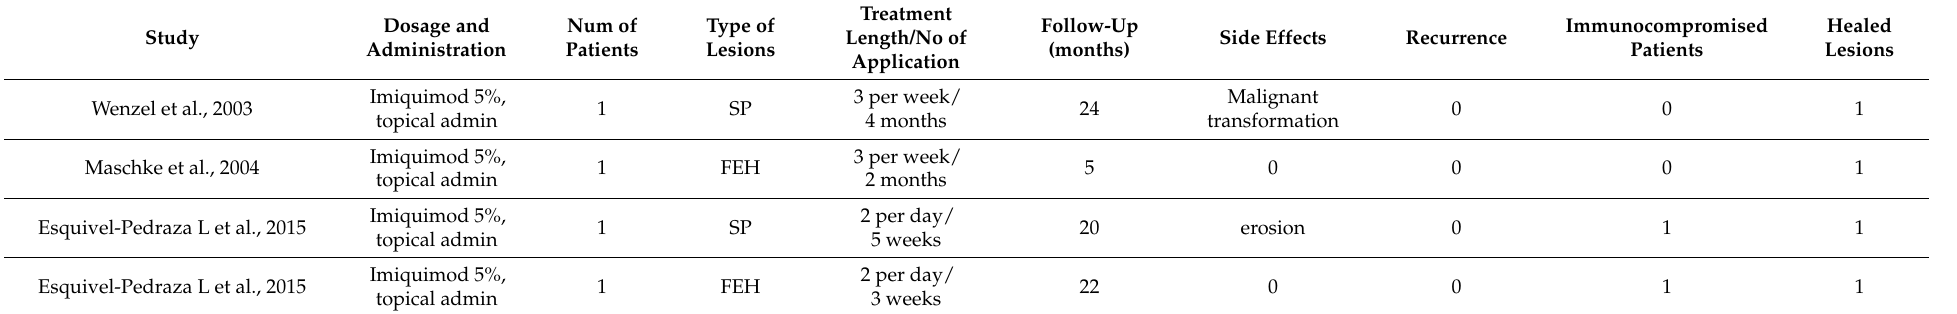
Table 2. Imiquimod studies.